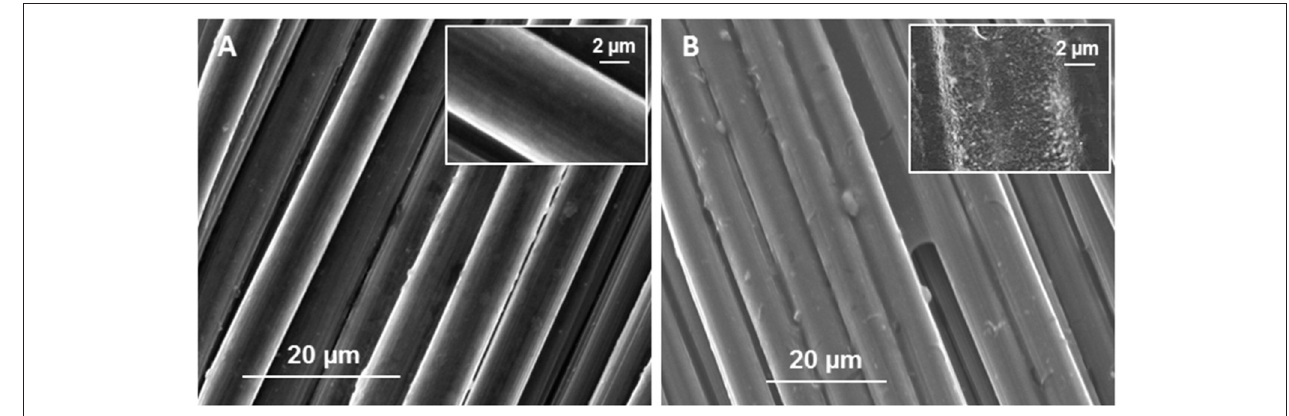
FIGURE 1 | SEM images of ( A ) sterile carbon cloth and sterile ( B ) carbon cloth coated with PEDOT:PSS.